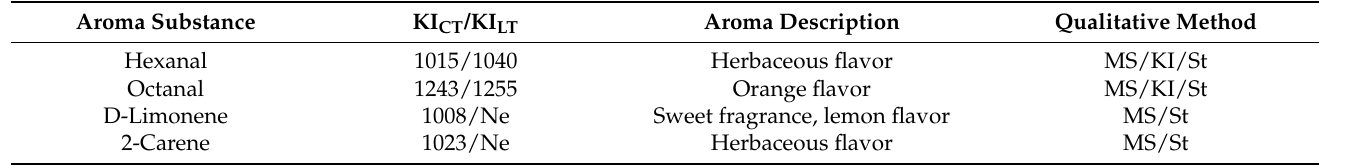
Table 2. The aroma substances of evident characteristics.